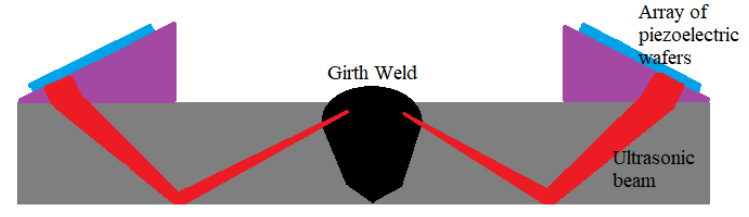
Figure 3. The schematic model of an ultrasonic phased array. Modified from